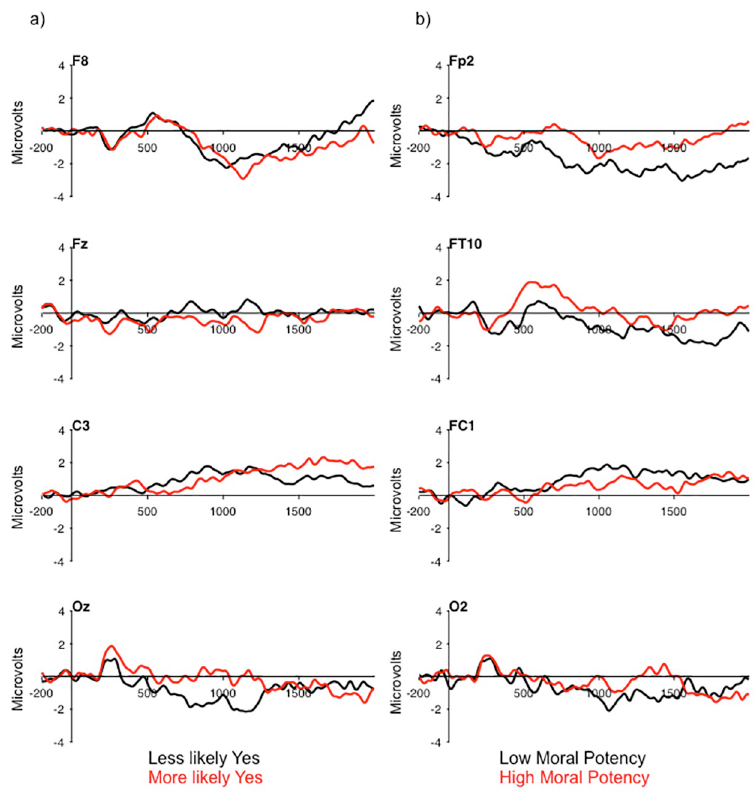
(violation minus control) reflecting a median split for moral